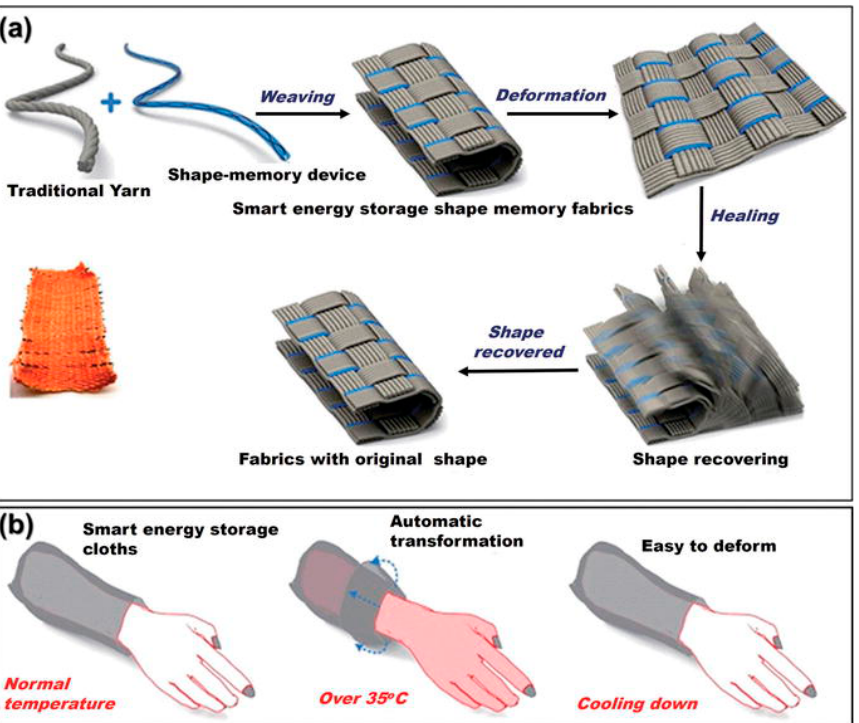
Figure 10. ( a ) Scheme of a shape memory supercapacitor woven hybridized with traditional fabric and ( b ) demonstration of the smart shape memory textile applied in an intelligent cloth (reproduced with permission from